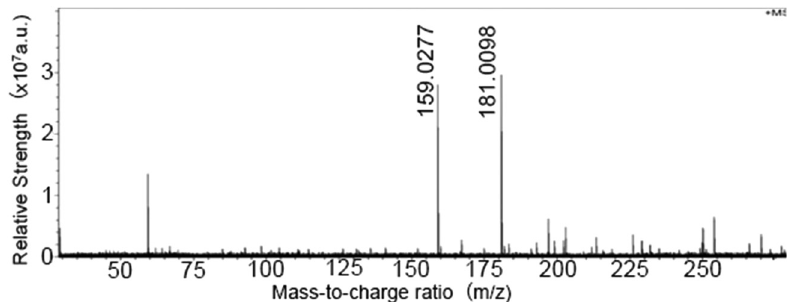
Figure 1: The mass spectrum of hypoxanthine with methanol as the solvent.